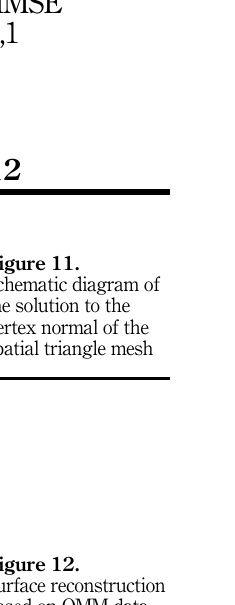
Figure 12. Surface reconstruction based on OMM data